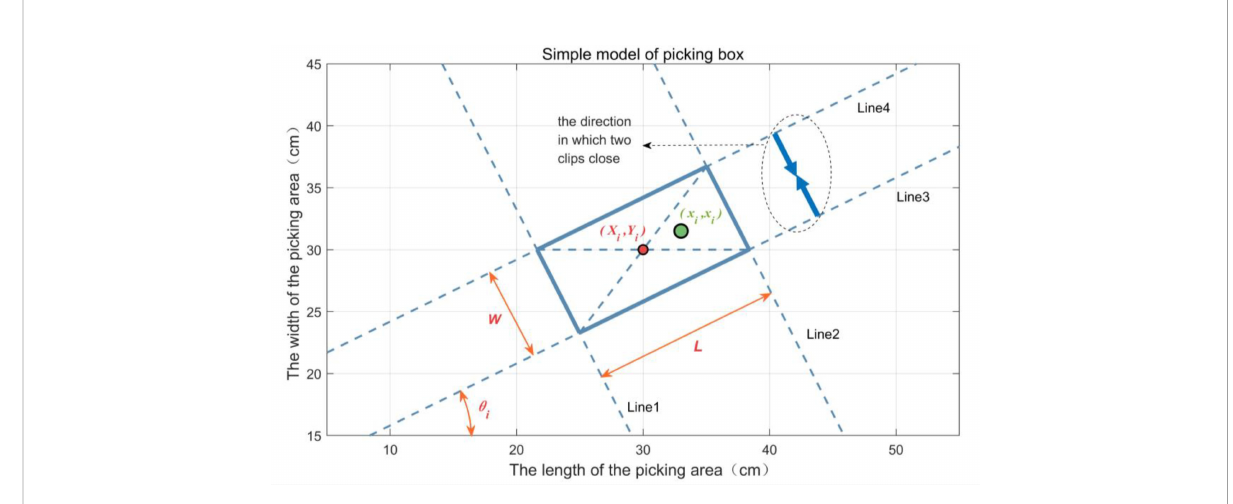
FIGURE 4 The picking box of the end of a bud